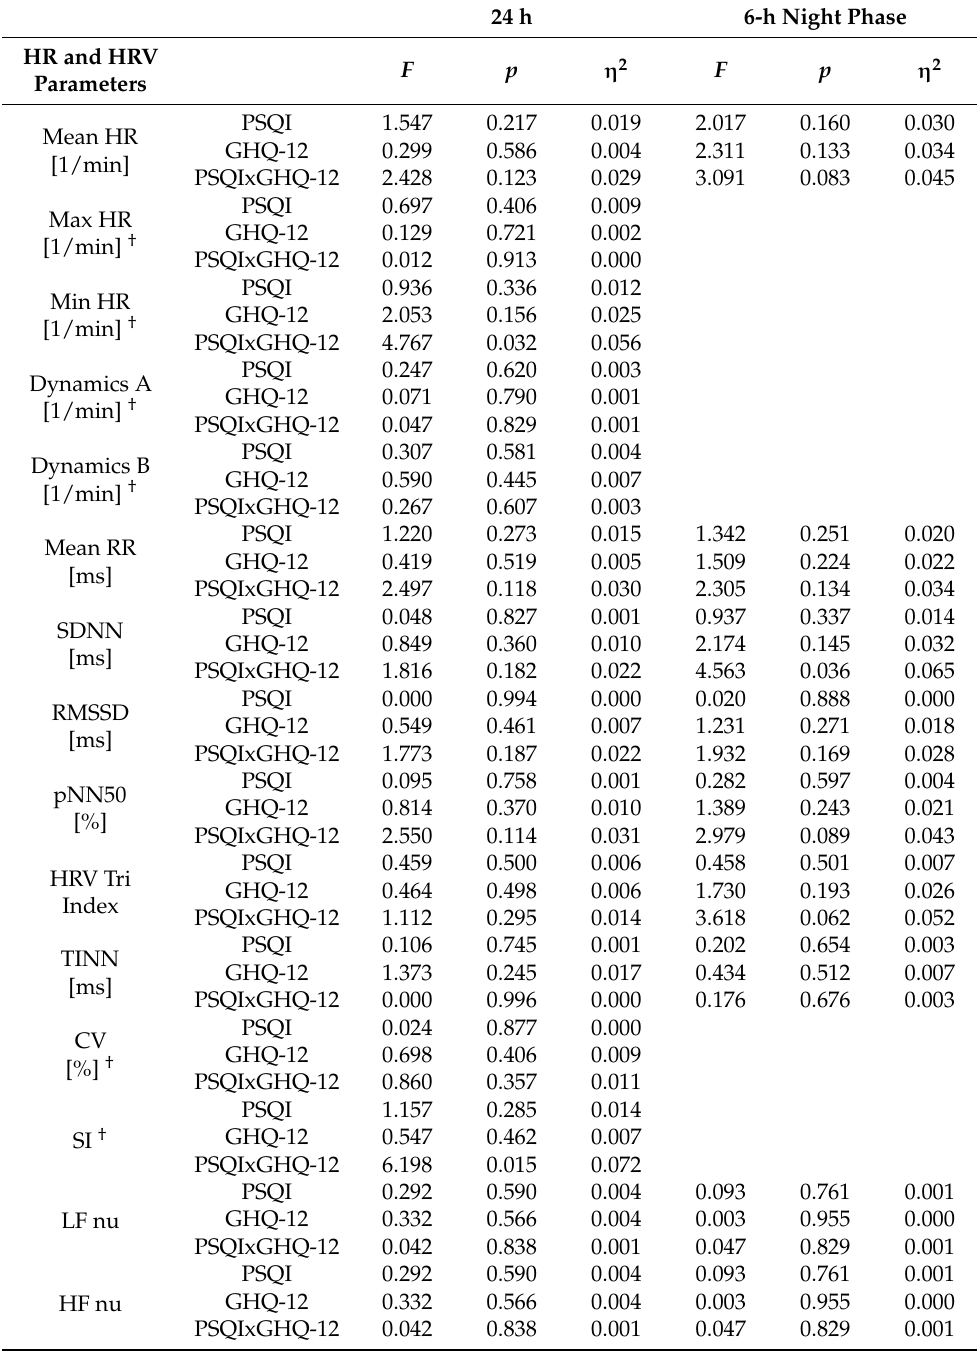
Table 4. Interaction effects between classification by sleep group (PSQI) and GHQ-12 for HR and HRV parameters of total time (24 h) and six–hour night